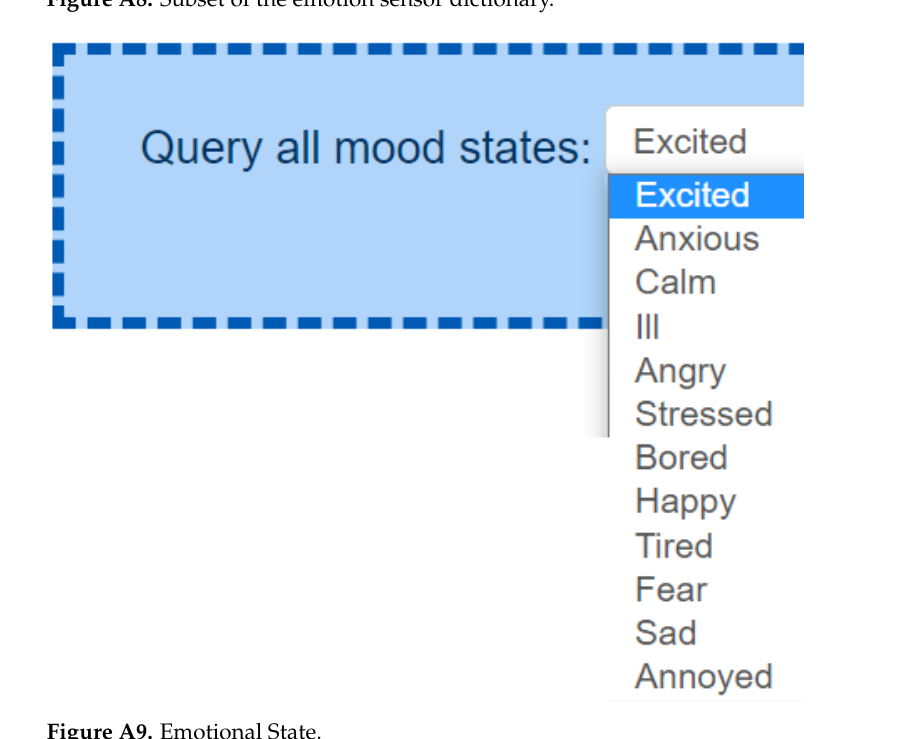
Figure A9. Emotional